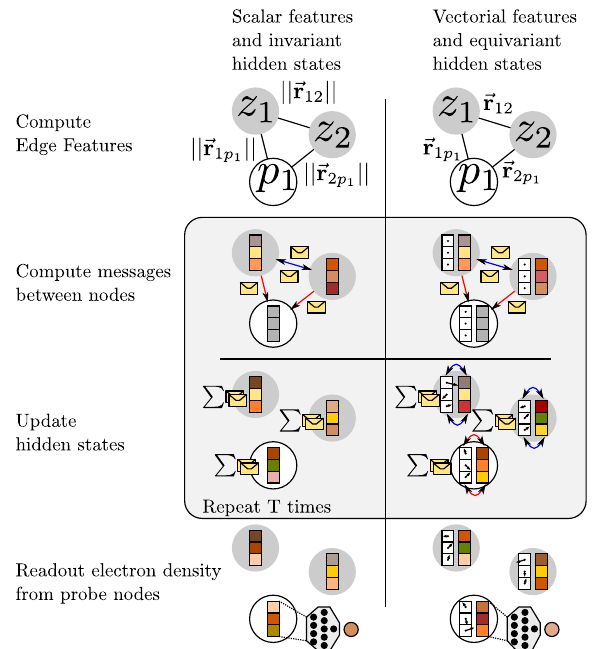
Fig. 1 Conceptual overview of the two message passing archi- tectures used in DeepDFT. The left column illustrates the invariant DeepDFT model and the right column illustrates the equivariant DeepDFT